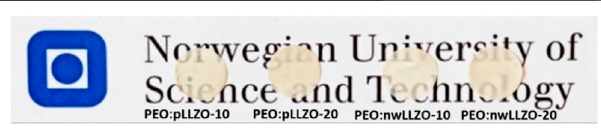
FIGURE 3 | Digital images of the as-prepared CE membranes.